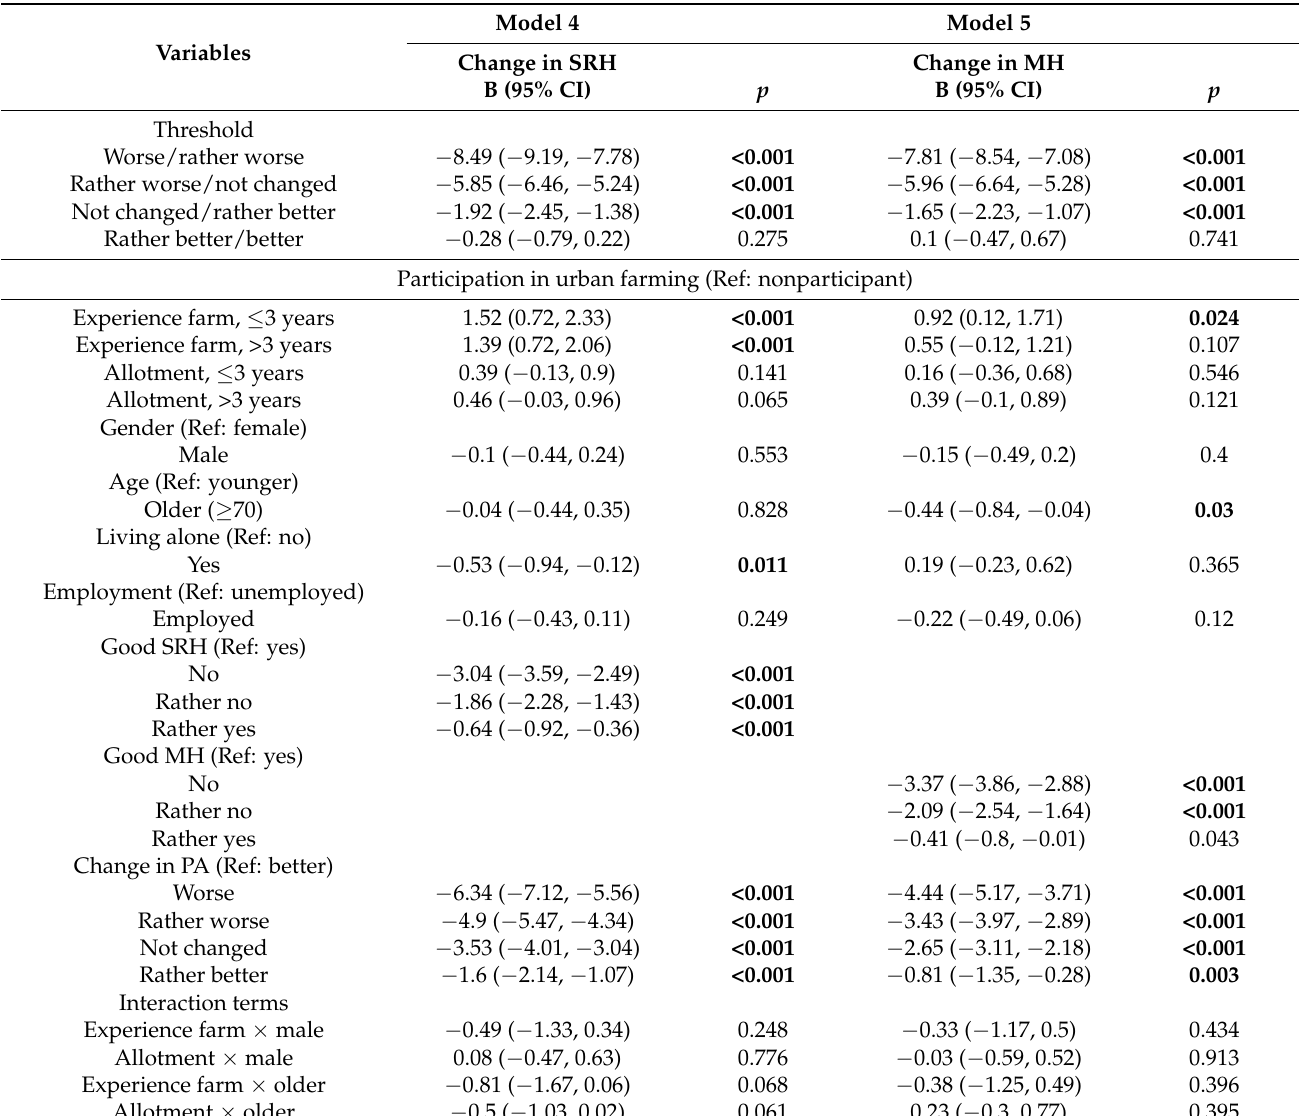
Table 3. The results of the ordinal logistic regression analyses (models 4 and